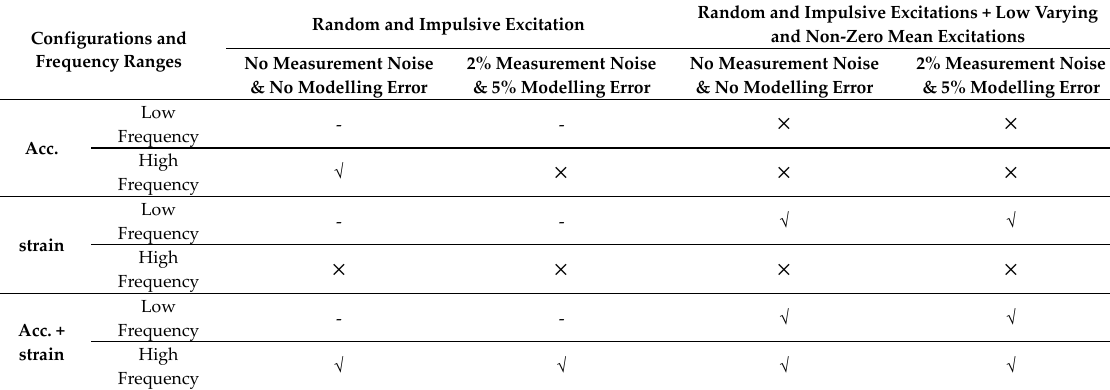
Table 2. Results summary for different cases. The symbols are: Yes (√), No ( ⨉ ), and Not Applicable (-). Configurations and Frequency